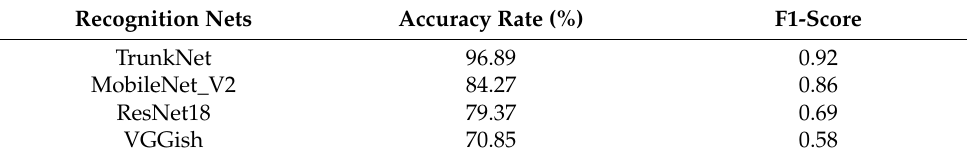
Table 3. Recognition